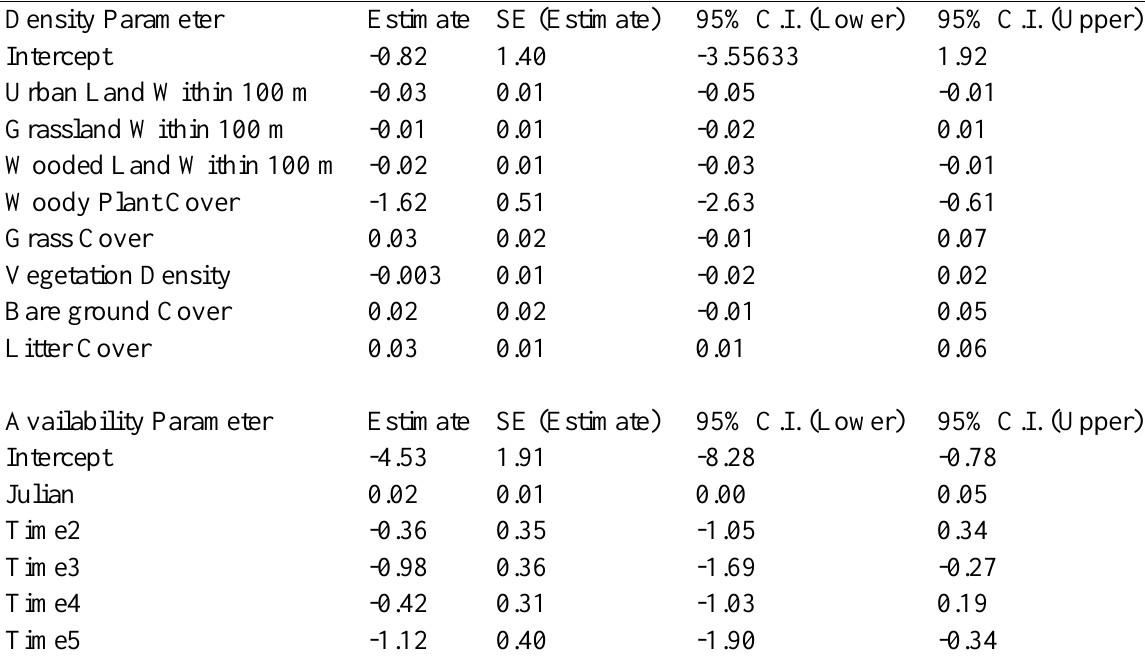
Table A2.D . Highest ranking hierarchical distance-sampling model for Clay-coloured Sparrows (AIC =683.13, ∆ AIC =0.00, AIC weight=0.73) along 46 transmission line study sites in c c Winnipeg, Manitoba, Canada in 2008 (n=138 surveys), assuming a uniform detection probability with increasing distance of birds from the transect line and effects of Julian date and time of morning but not observer experience on availability for